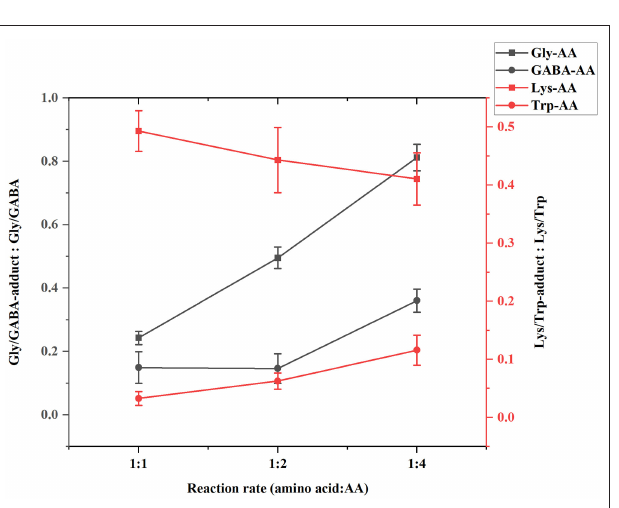
system at pH 11.75 and 180 ◦ C for 2 h, but they did not share the spectrum.